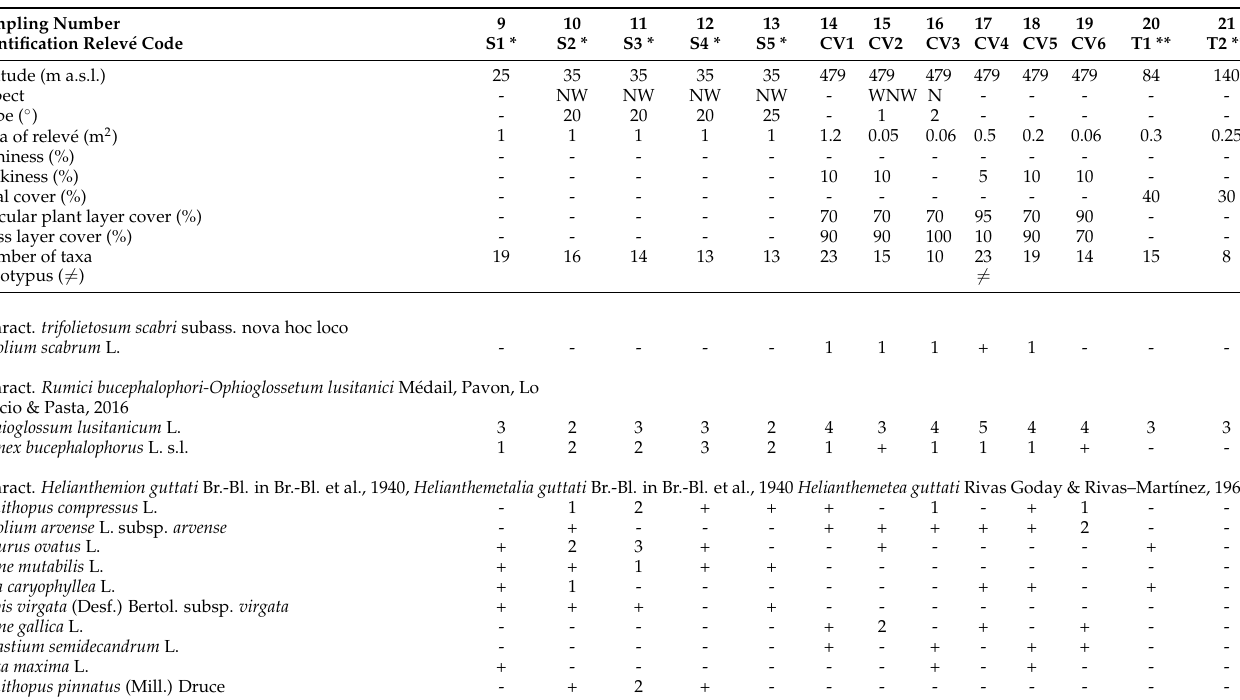
Figure 6. Rumici bucephalophori-Ophioglossetum lusitanici subass. trifolietosum scabri subass. nova hoc loco. Date: 19 March 2016, Mt. Vesuvius, Ercolano, between Casa Cantoniera and Osservatorio Vesuviano (Naples). Photo by Adriano Stinca.